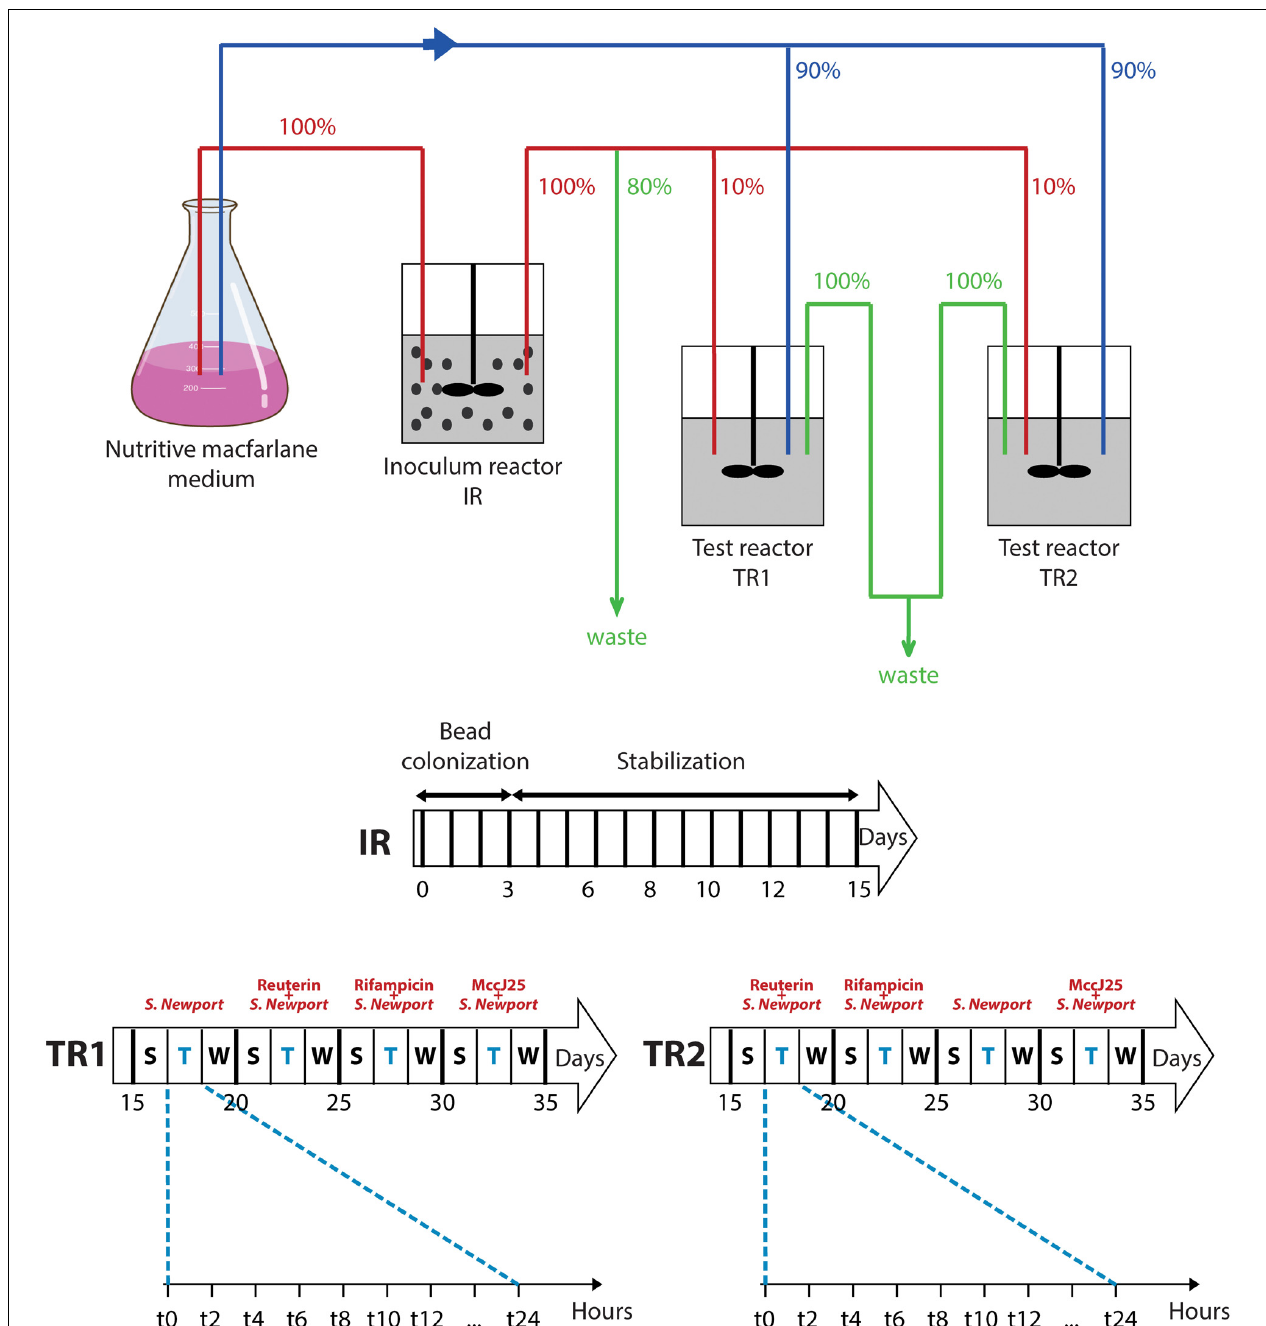
FIGURE 2 | PolyFermS model set-up and experimental treatment schedule. Relative flow rates are indicated in percentage. IR, inoculum reactor containing pig fecal bacteria immobilized in gel beads (30% v/v); TR1, TR2, test bioreactors; S, stabilization period; T, treatment period; W, wash